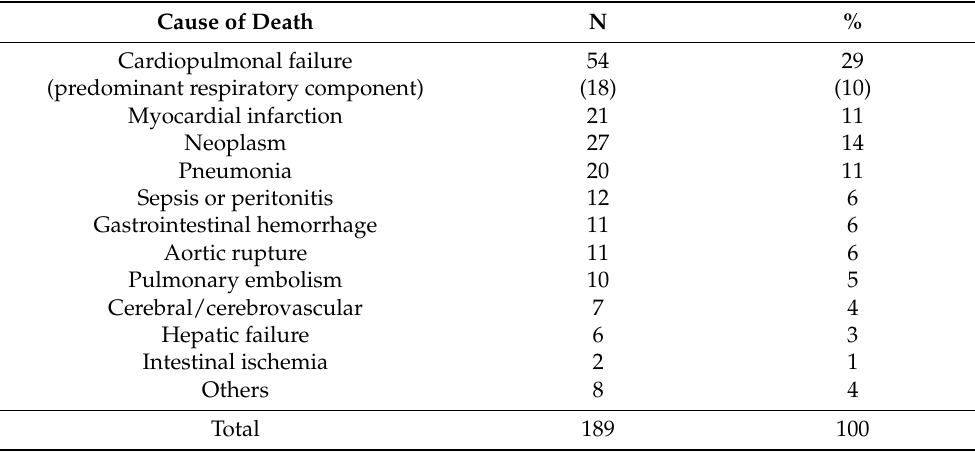
Table 1. Cause of death in consecutive adult autopsies from a 2-year period (2016–2017). Cause of Death N % Cardiopulmonal failure 54 29 (predominant respiratory component) Myocardial